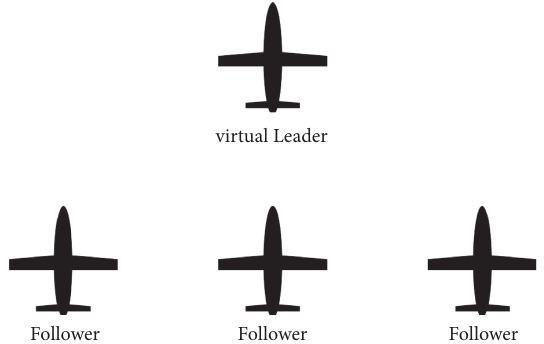
Figure 3: Virtual leader formation